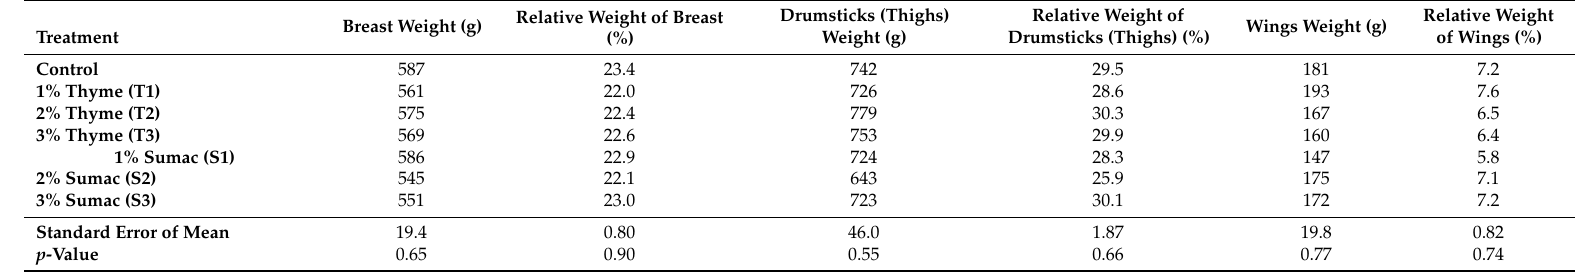
Table A1. Mean ( ± SEM) of economically valuable parts in relation to eviscerated carcass at 42nd days of age in Ross 308 broilers fed diets containing 0, 1, 2 and 3% Thyme (T3) and sumac from days 29–42.